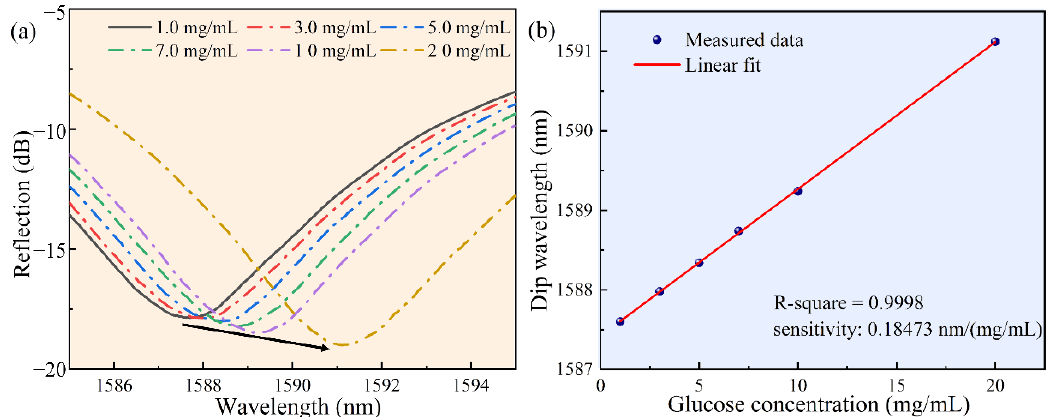
Figure 7. The results of measuring the glucose concentration in serum solution, under the wavelength ranging from 1580 to 1600 nm. ( a ) The reflectance spectrum as a function of glucose concentration. ( b ) The linear curve fitting of the dip wavelength and glucose concentration in serum.